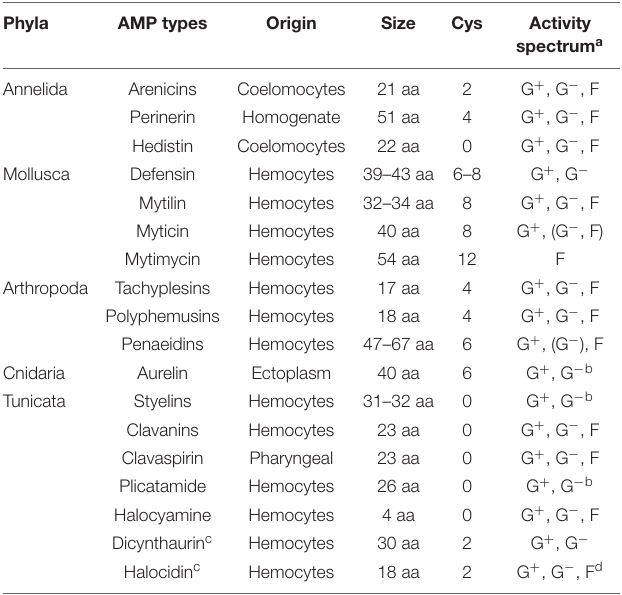
TABLE 1 | Overview of the gene-encoded AMPs from marine invertebrates, including some key